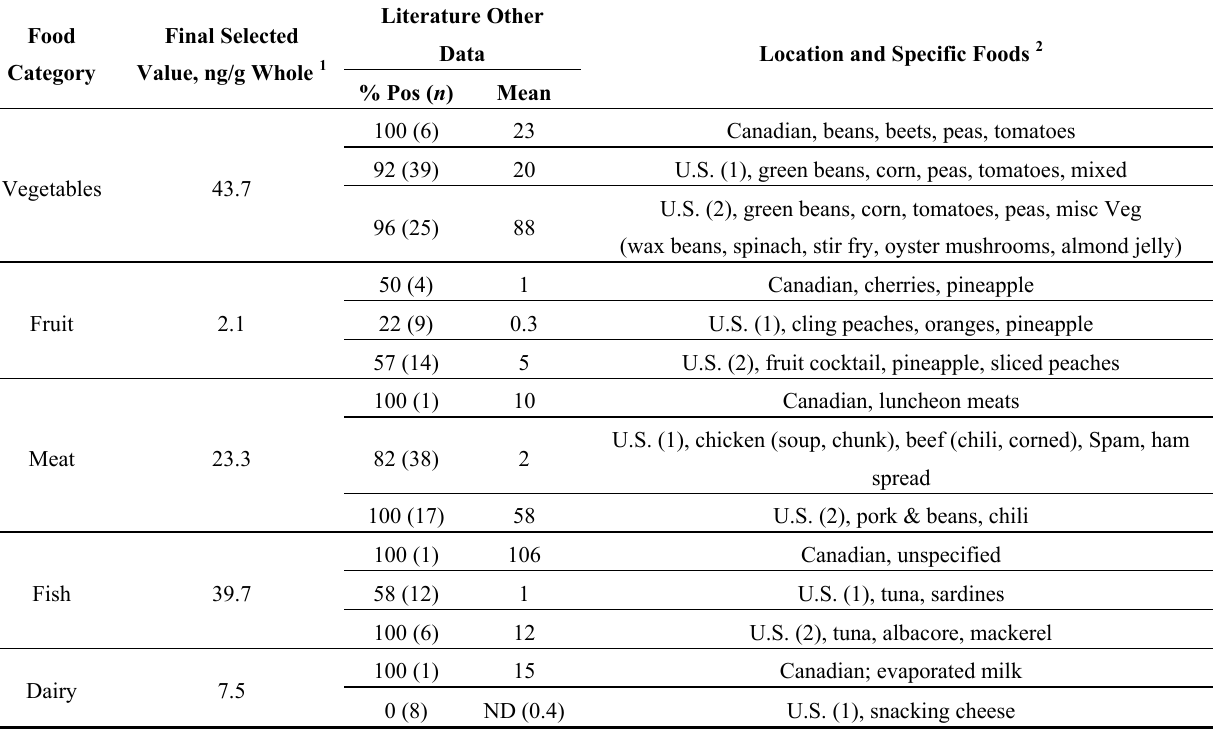
Table A2. U.S. and Canada studies * reporting BPA concentrations in canned